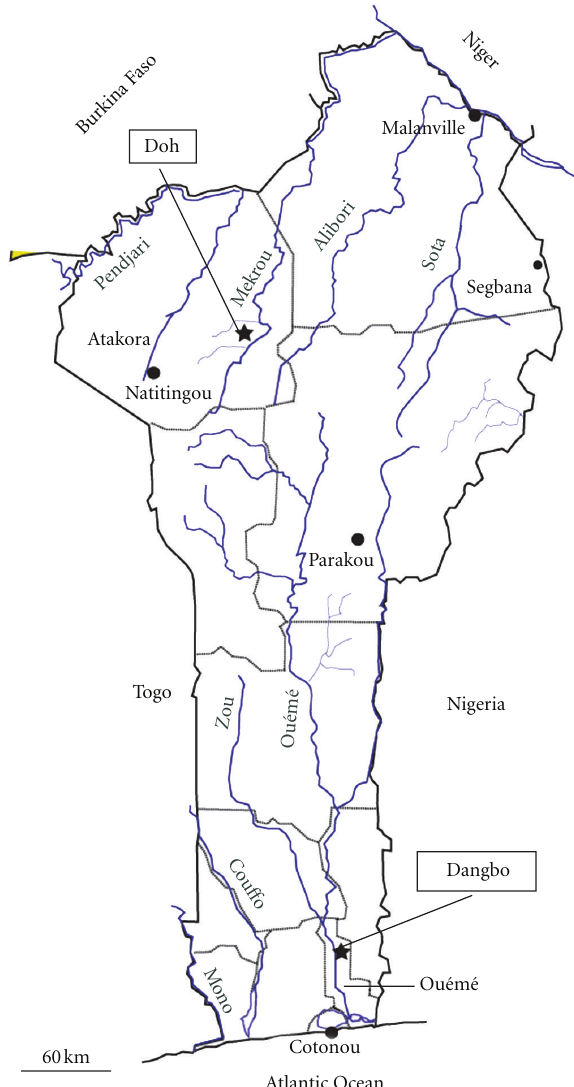
Figure 1: Locations of the study sites of Doh (north Benin) and Dangbo (south